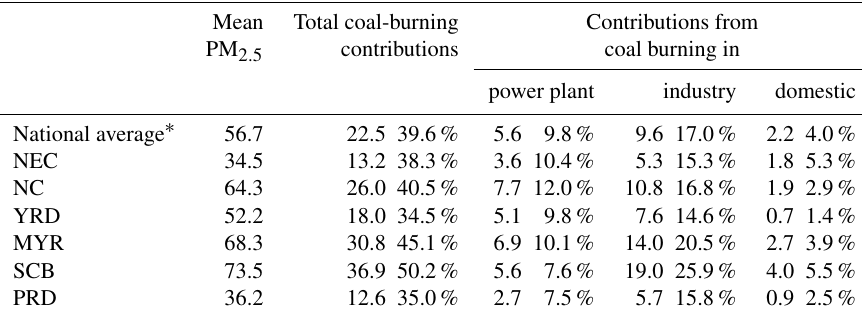
Table 3. Annual mean absolute contributions (µgm − 3 ) and percentage contributions from coal burning. Mean Total coal-burning Contributions from PM 2 . 5 contributions coal burning in power plant industry domestic National average ∗ 56.7